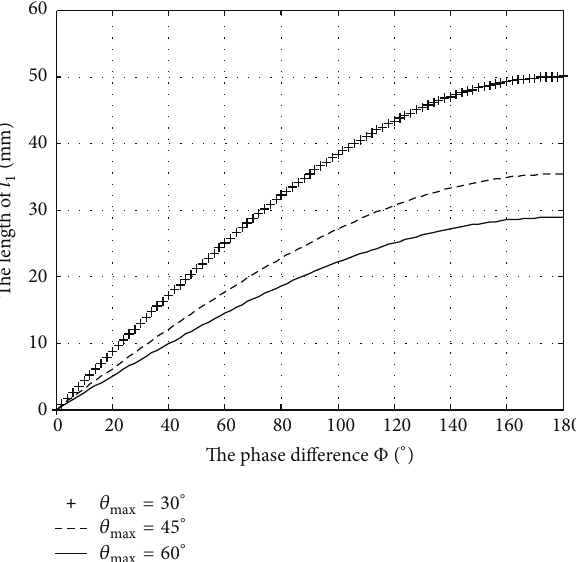
Figure 6: The rod length of the tail link varies with the phase difference.